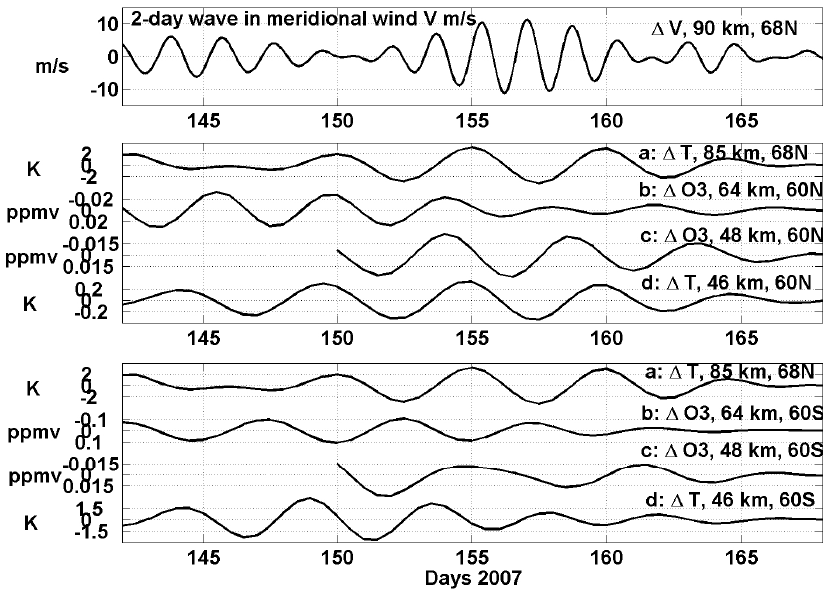
Fig. 8. Wave perturbations for 22 May–17 June 2007: Upper panel: 2-day wave from ground-based radar measurements of meridional wind (m/s) over Esrange (67 ◦ 56 0 N, 21 ◦ 04 0 E), at 90km. Middle panel: 5-day perturbations:: a) from ground-based radar measurements of temperature over Esrange (67 ◦ 56 0 N, 21 ◦ 04 0 E), at 85km. (b–d) from Odin retrievals at latitude=60 ◦ N, longitude=21 ◦ E: for ozone (ppmv) at 64km (b) and at 48km (c), for temperature (K) at 46km (d), (Note: reverse scale for ozone). Lower panel: (a) same as on the middle panel. (b–d) same as on the middle panel but for latitude=60 ◦ S. (Note: reverse scale for